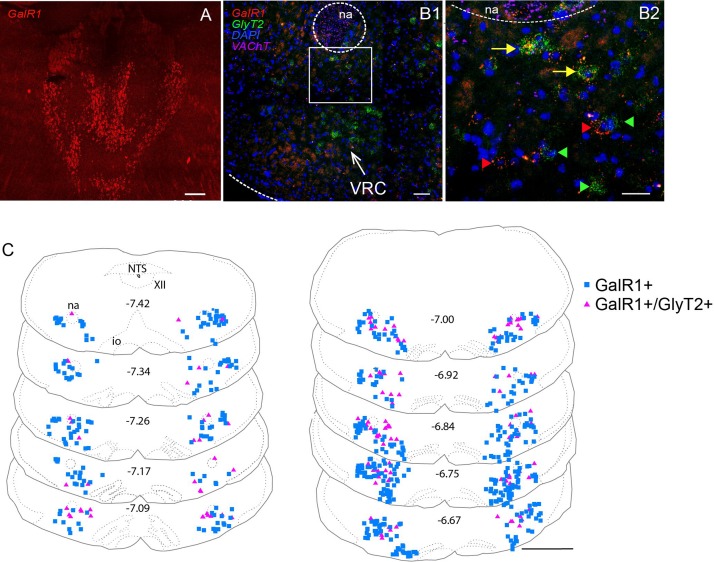
Distribution of GalR1 mRNA expressing neurons in the VLM. (A) The GalR1 FISH riboprobe demonstrated labeling of specific thalamic nuclei as described previously [Supplementary Figures S1A (adapted from Kerr et al., 2015), 1B]. (B1) GalR1 and GlyT2 mRNA labeling was observed ventral to nucleus ambiguus (na), in a region corresponding to the VRC. (B2) Inset in B1 enlarged, showing GalR1+ (red arrowhead), GlyT2+ (green arrowhead) and GalR1+/GlyT2+ double labeled (yellow arrow) neurons. (C) Representative mouse brainstem coronal sections, showing GalR1 and GlyT2 mRNA labeling from Bregma level −7.42 to −6.67. Scale bars are 200 μm (A), 50 μm (B1), 25 μm (B2) and 1 mm (C).